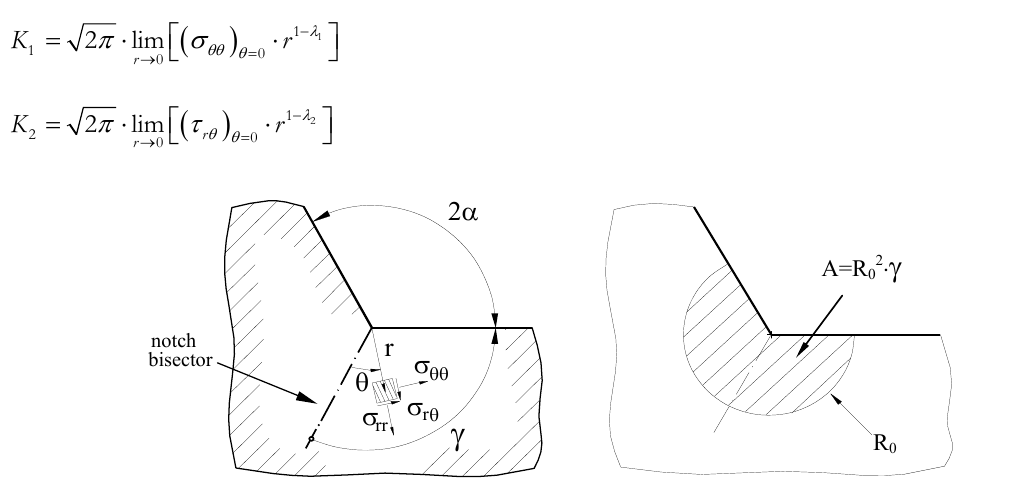
Figure 1: (a) Polar coordinate system centred at the notch tip. (b) Control volume (area) of radius R 0 surrounding the V-notch tip. where (r, θ ) is a polar coordinate system centred at the notch tip (Fig. 1a), σ θθ and τ r θ are the stress components according to the coordinate system and λ 1 and λ 2 are the mode I and mode II first eigenvalues in William’s equations [6], respectively. The condition θ = 0 characterizes all points of the notch bisector line. When the V-notch angle 2 α is equal to zero, λ 1 and λ 2 equal 0.5 and K 1 and K 2 match the conventional stress intensity factors of a crack, K I and K II, according to the Linear Elastic Fracture Mechanics